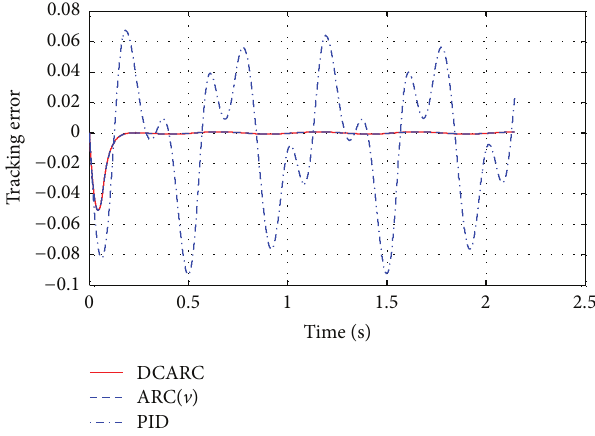
Figure 6: Tracking errors for a fast sinusoidal curve in the presence of parametric uncertainties and uncertain